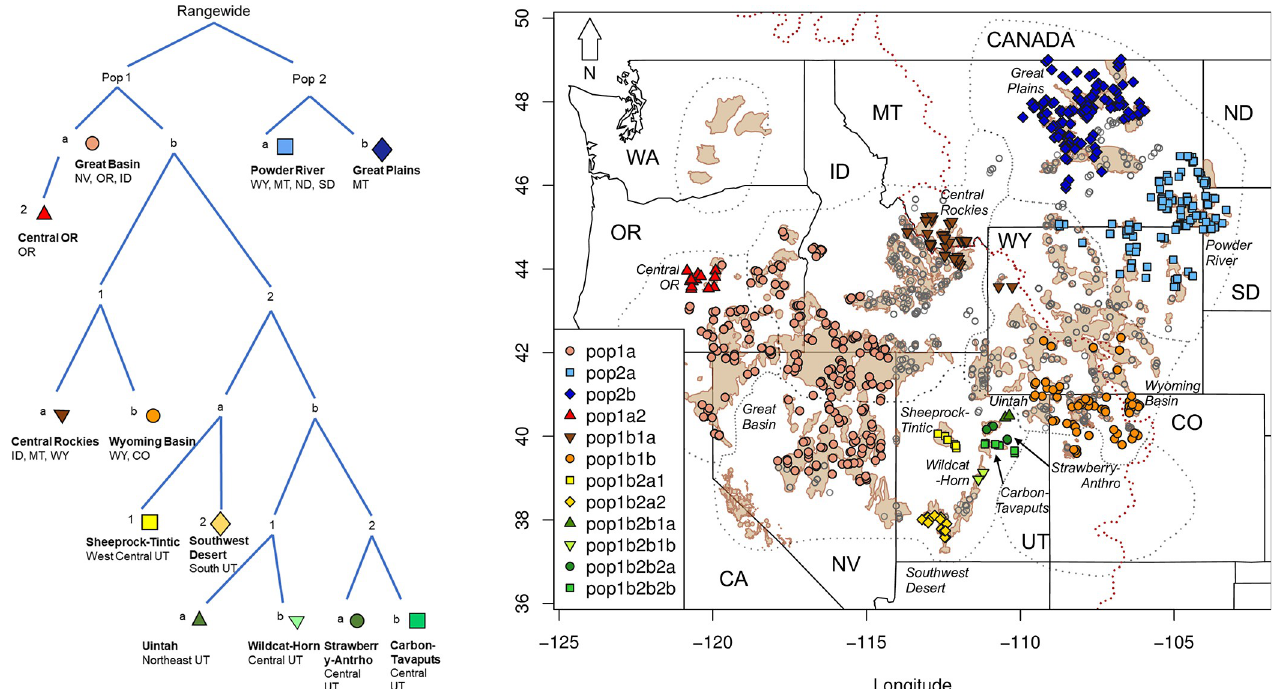
Fig 4. (A) Diagram showing how Greater Sage-grouse subpopulation centers were identified using 6 rounds of spatial iterative bifurcation process (for detailed interpolated maps and a summary of individuals included in each bifurcation, see S5 and S6 Figs) and (B) the distribution of individuals in each subpopulation center with color and symbol representing the 12 subpopulation centers. Open grey symbols represent individuals that occur outside of the subpopulation centers. The dotted red line represents the Continental Divide. Tan polygons represent Priority Areas for Conservation and dotted black lines represent the seven sage-grouse management zones (MZ). State names are represented by the following abbreviations California (CA), Colorado (CO), Idaho (ID), Montana (MT), Nevada (NV), North Dakota (ND), Oregon (OR), South Dakota (SD), Utah (UT), Washington (WA), and Wyoming (WY).